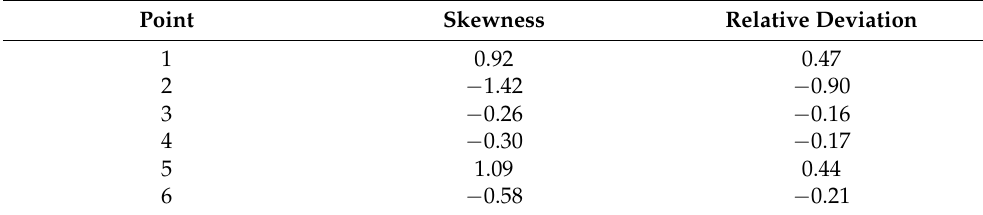
Table 2. Calculated skewness and relative